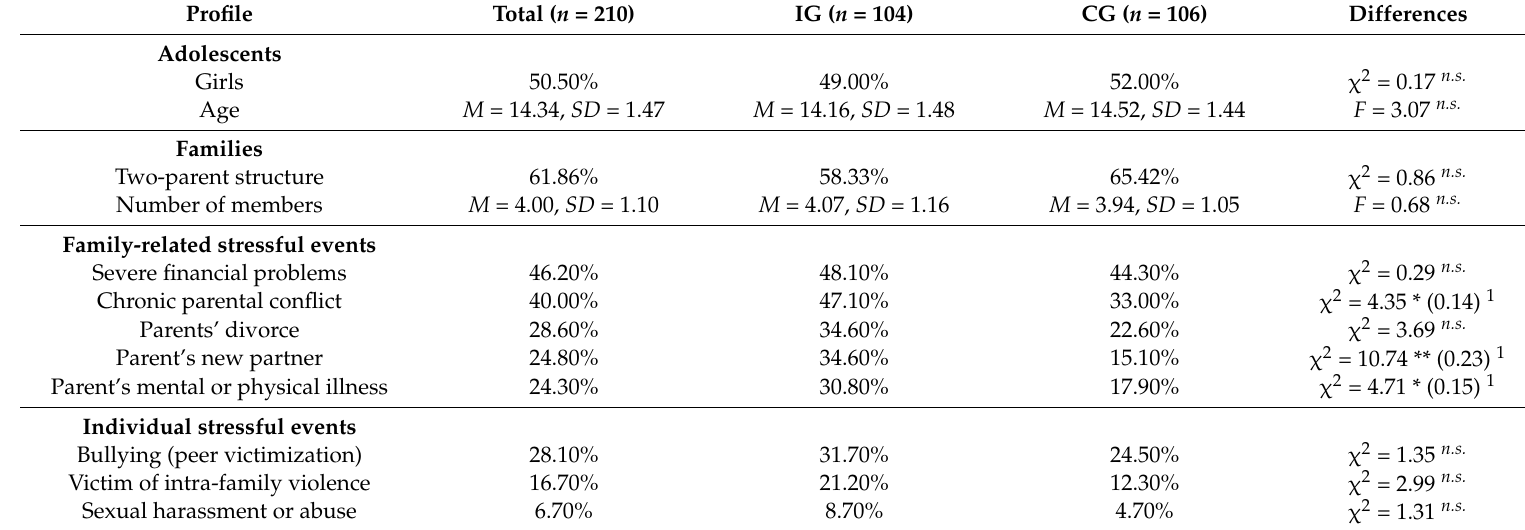
Table 1. Baseline Characteristics for the Intervention Group (IG) and the Control Group (CG): Sociodemographic and Psychosocial Stress